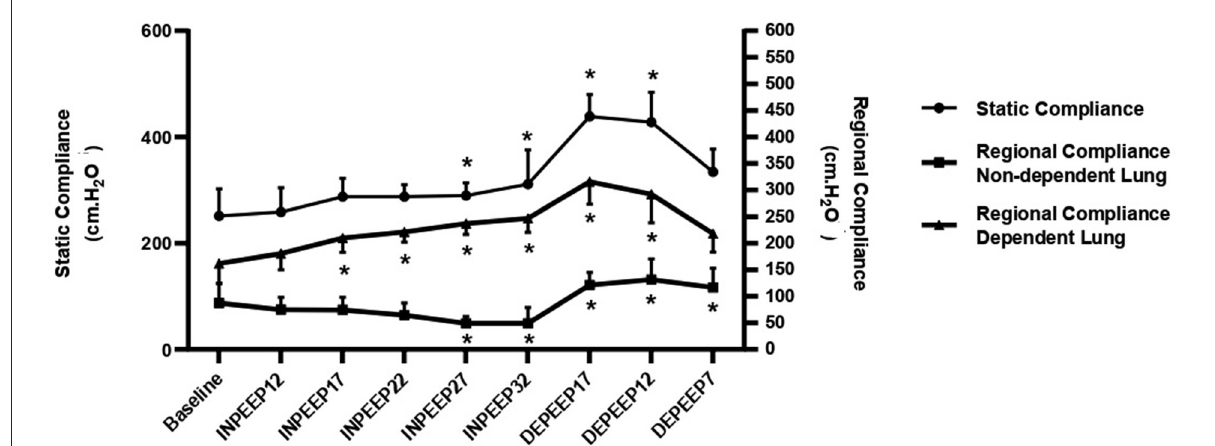
FIGURE1 Variation of the static lung compliance (closed circle), regional compliance of non-dependent lung (closed triangle), and regional compliance of dependent lung (closed square) represented by mean ± standard deviation during recruitment maneuver for PEEP titration. PEEP: positive end-expiratory pressure; Baseline: 7 cmH 2 O of PEEP; INPEEP12: PEEP 12 cmH 2 O increase; INPEEP17: PEEP 17 cmH 2 O increase; INPEEP22: PEEP 22 cmH 2 O increase; INPEEP27: PEEP 27 cmH 2 O; INPEEP32: PEEP 32 cmH 2 O increase; DEPEEP17: PEEP 17 cmH 2 O decrease; DEPEEP12: